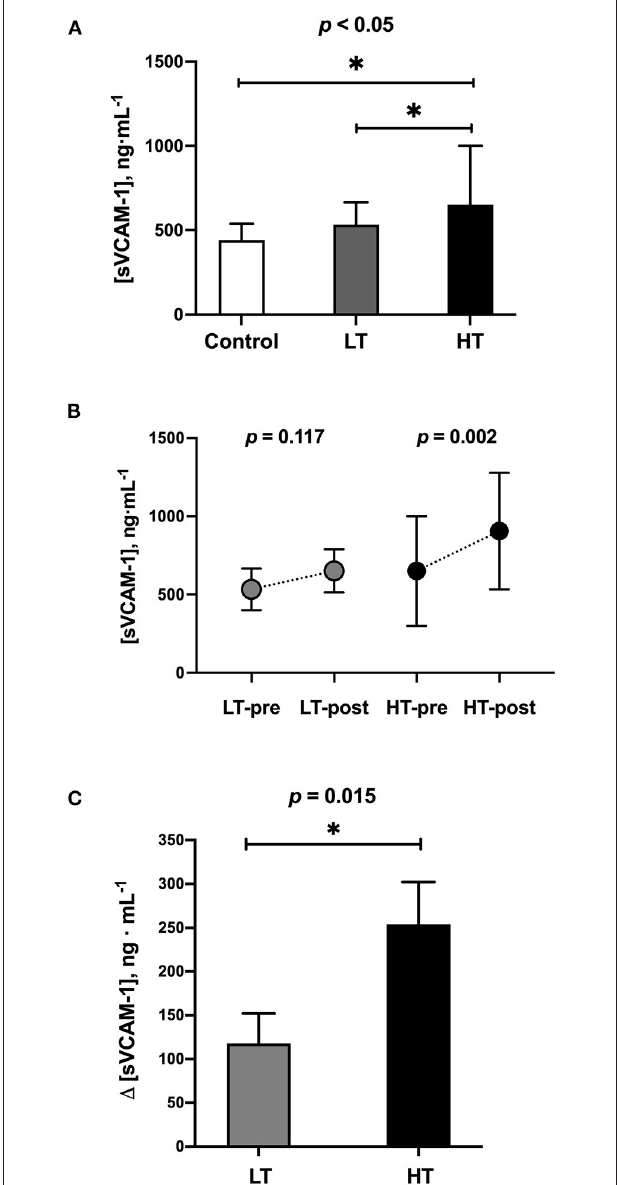
FIGURE 2 | Blood samples levels of sVCAM-1. (A) At baseline conditions (1 week before marathon race). (B) Exercise-induced changes after marathon race (42.2km). (C) Comparison of changes ( 1 sVCAM-1 = post–pre-marathon) between runners’ groups. LT, low training ( ≥ 70 and < 100 km · week − 1 ) ( n = 18); HT, high training ( ≥ 100 km · week − 1 ) ( n = 18). * = p -value < 0.05.